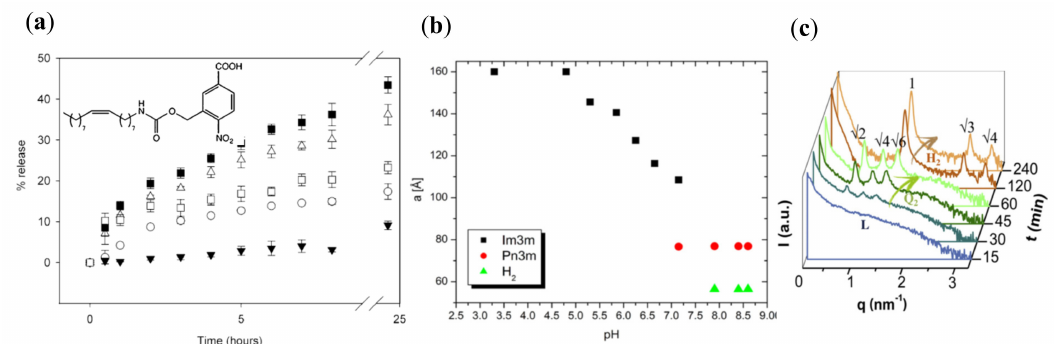
Figure 5. ( a ) Percentages of guest molecule MG (methylene green zinc chloride double salt) release as a function of time from the aqueous compartments of the following five lipid cubic phases: monoolein, pH 7 (white squares); monoolein / Lipid 3 (inserted), pH 7 (black triangles); monoolein / Lipid 3, pH 5 (white circles); monoolein / Lipid 3, pH 3 (white triangles); monoolein / Lipid 3, pH 2.5 (black squares; reproduced from [71], with permission from Wiley-VCH Verlag GmbH & Co., 2020). ( b ) Lattice parameters as a function of pH for monoolein-nicergoline dispersions (reproduced from [72], with permission from the American Chemical Society, 2020). ( c ) Time-resolved SAXS profiles showing phase transitions of lipid dispersions induced by a guest molecule (DBC), which hydrolyzes from neutral to alkaline media (reproduced from [75], with permission from Elsevier,